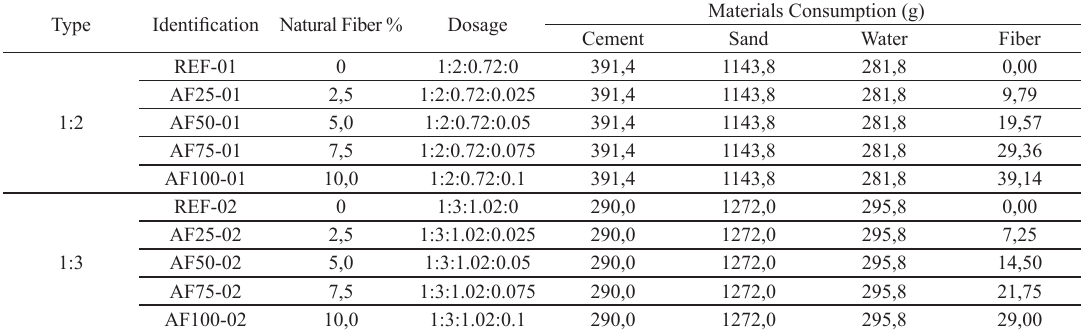
Table 2. Used dosages. Type